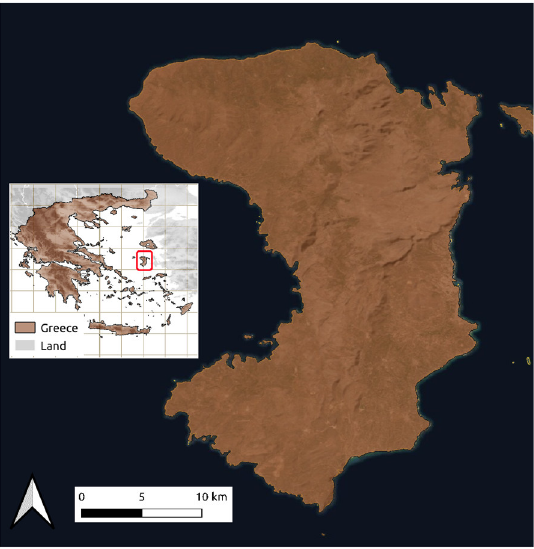
Figure 2. The study area, island of Chios, and its relative location to Greece (inset).